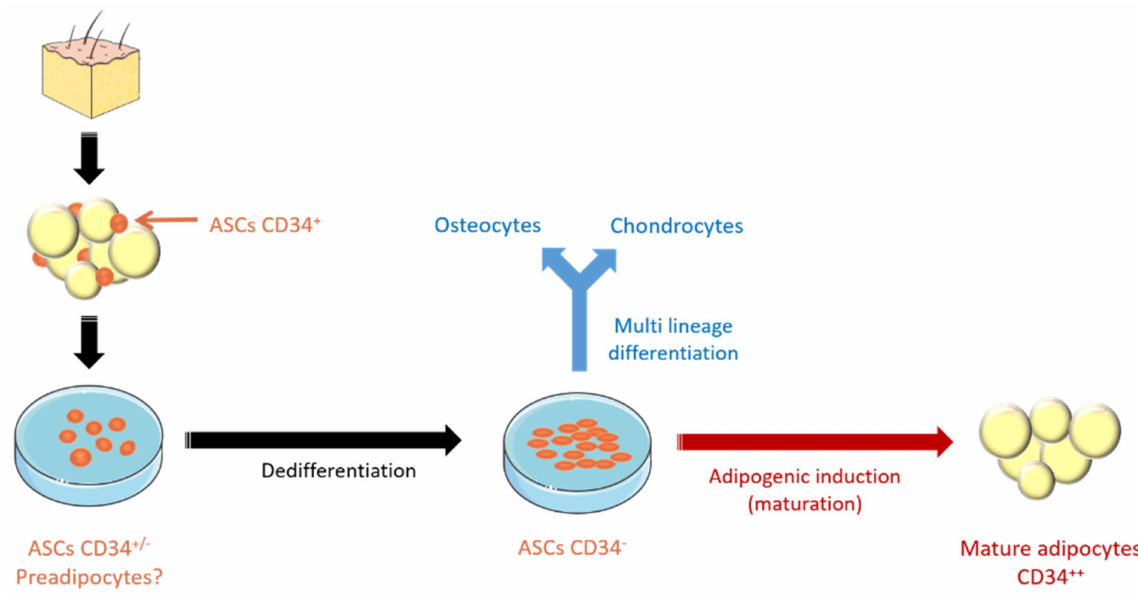
Figure 13. Preadipocytes’ dedifferentiation induced by the ex vivo cell culture